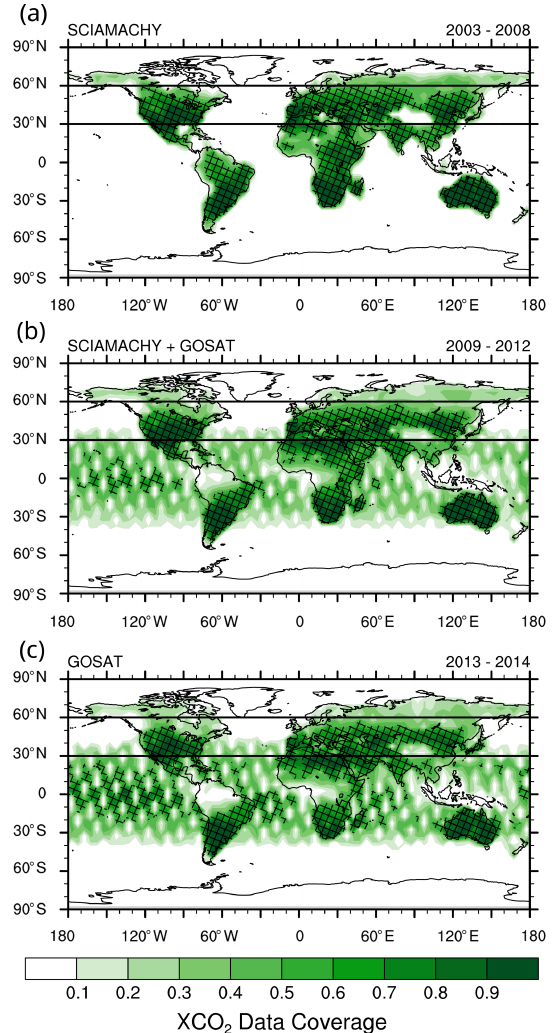
Figure 8. Data coverage of the satellite observations for (a) 2003– 2008 containing only SCIAMACHY data, (b) 2009–2012 contain- ing the overlap of SCIAMACHY and GOSAT data and (c) 2013– 2014 containing only GOSAT data. The patterned area highlights values above